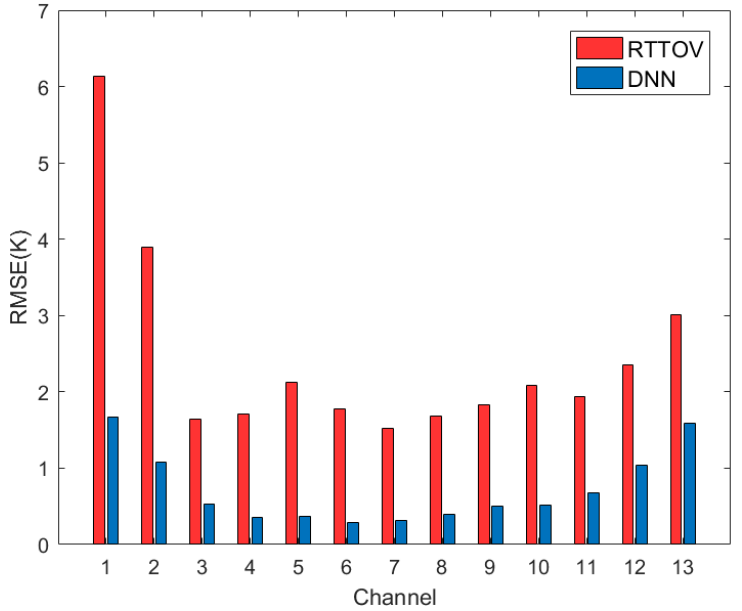
Figure 5. The accuracy comparison between the DNN-based model for MWTS-II simulations and RTTOV.